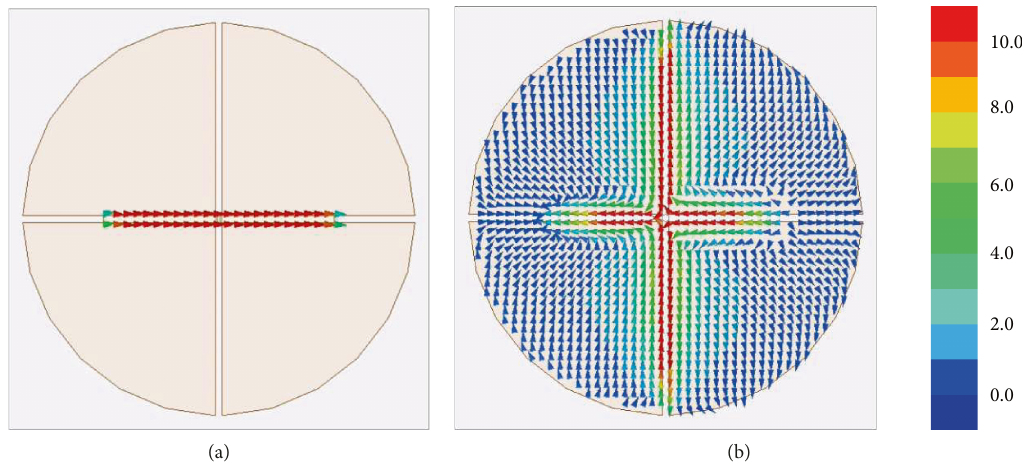
Figure 4: Surface current distributions on (a) single dipole and (b) parasitic patches at Table 1: Performance comparison of the dipole antennas with parasitic elements. Structure Pro fi le